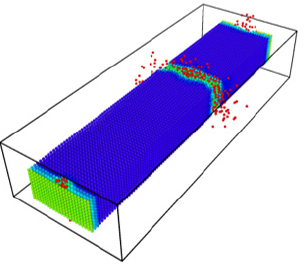
Figure 8. Broken bitumen sample in the simulation.